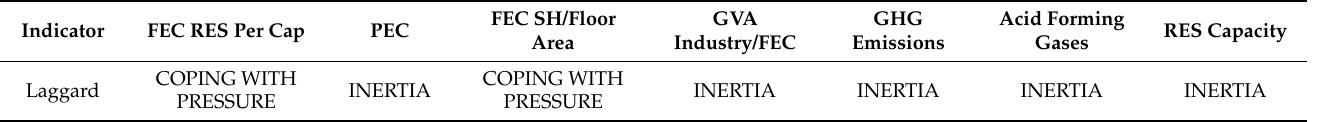
Table 5. Identified “laggards” in the six